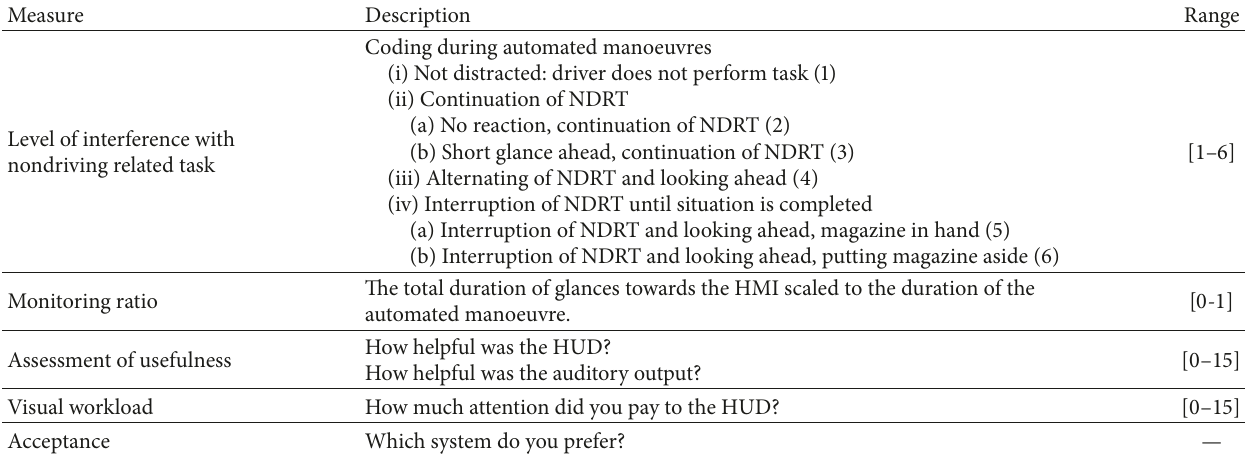
Table 2: Dependent measures and description of